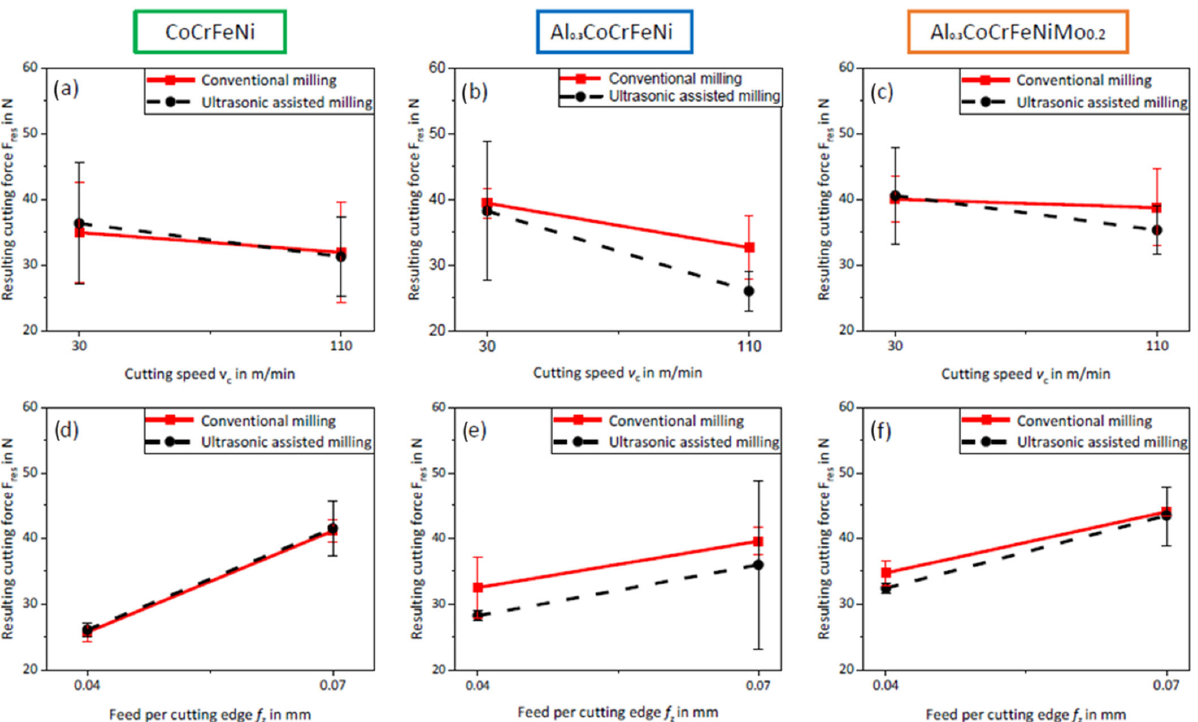
Figure 4. For CoCrFeNi, Al 0.3 CoCrFeNi, and Al 0.3 CoCrFeNiMo 0.2 , influence of cutting speed ( a – c ) and feed per cu tt ing edge ( d – f ) on resulting cu tt ing force.